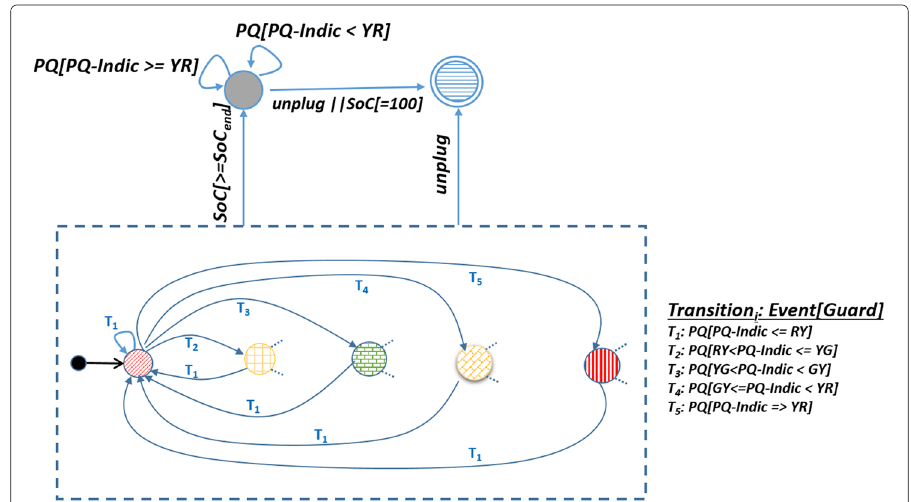
Fig. 5 FSM of the Smart Charger based on the traffic light model: For simplification within the box containing the operational states, only the outgoing and incoming transitions of the “low red” state are shown. All other states are connected similarly to each other. Furthermore, the state machine can transit from any operational states to the standby and end